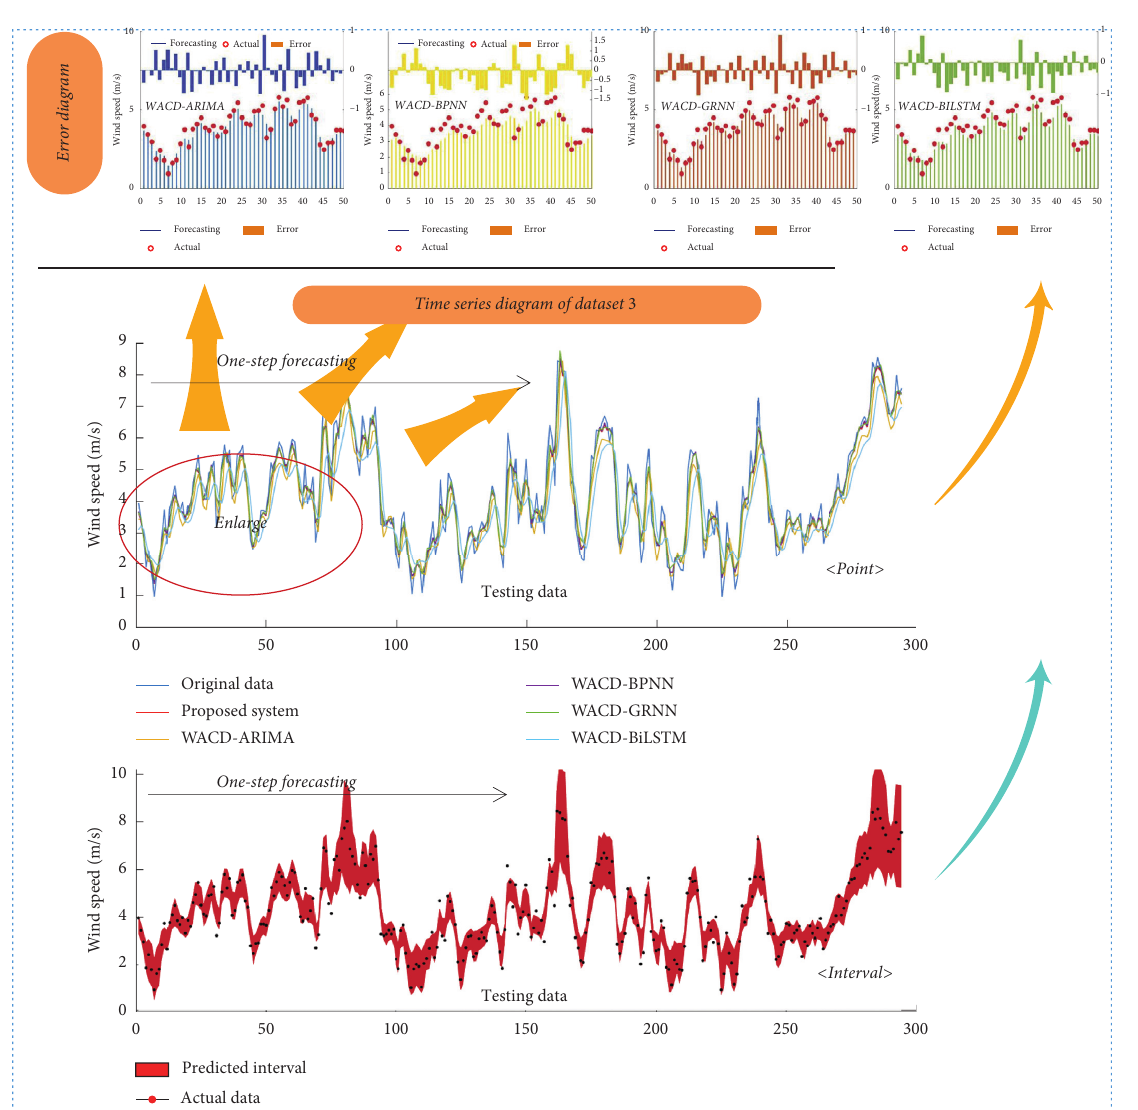
Figure 2: Experiment I: comparison with other WACD-based